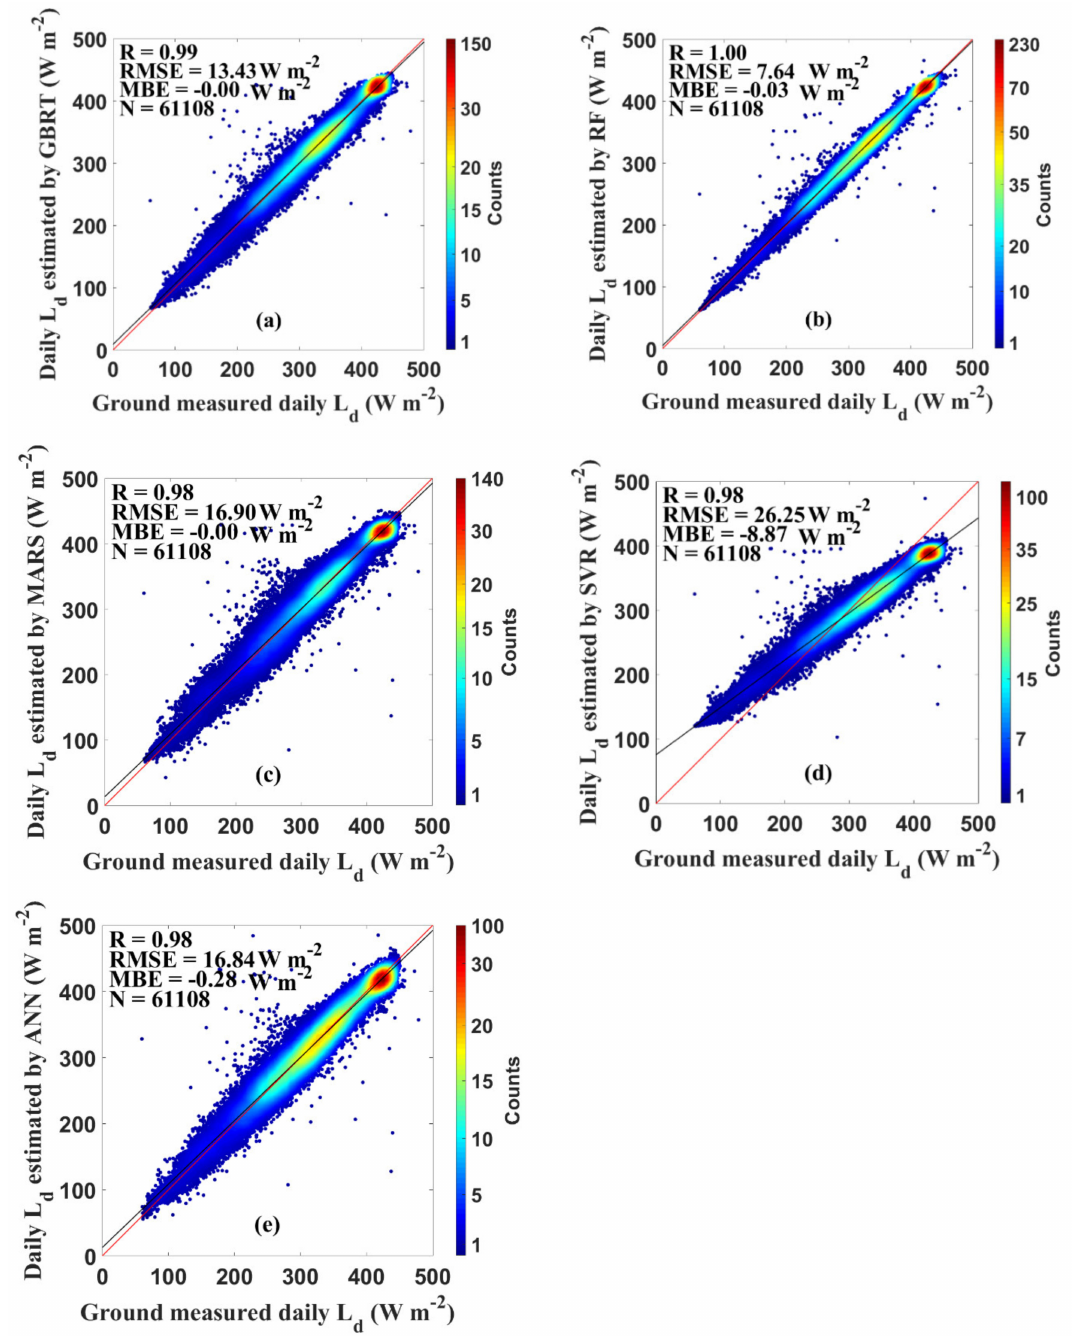
Figure 2. Evaluation results of the daily L d estimates on the basis of the ( a ) gradient boosting regression tree (GBRT), ( b ) random forest (RF), ( c ) multivariate adaptive regression spline (MARS), ( d ) support vector regression (SVR), and ( e ) artificial neural network (ANN) methods against the ground measurements on the training dataset. N is the number of data records. The red and black lines represent the 1:1 and fitted lines,